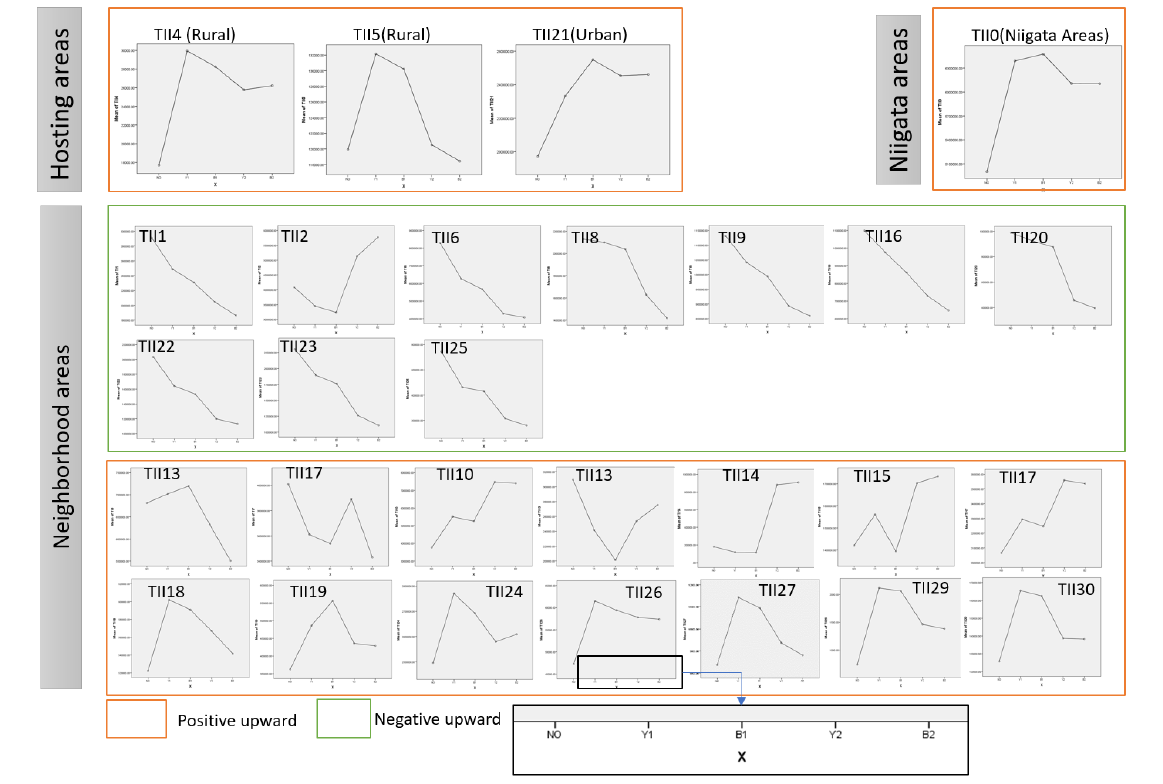
Figure 8. Mean plots (TII, TIIGR): other areas in Niigata.